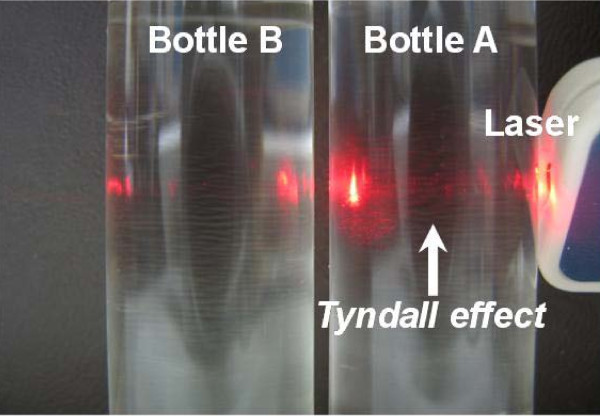
Alcohol/PAO nanoemulsion fluids (Bottle A) and pure PAO (Bottle B). Liquids in both bottles are transparent. The Tyndall effect (i.e., a light beam can be seen when viewed from the side) can be observed only in Bottle A when a laser beam is passed through Bottles A and B. Pictures taken using a Canon PowerShot digital camera.